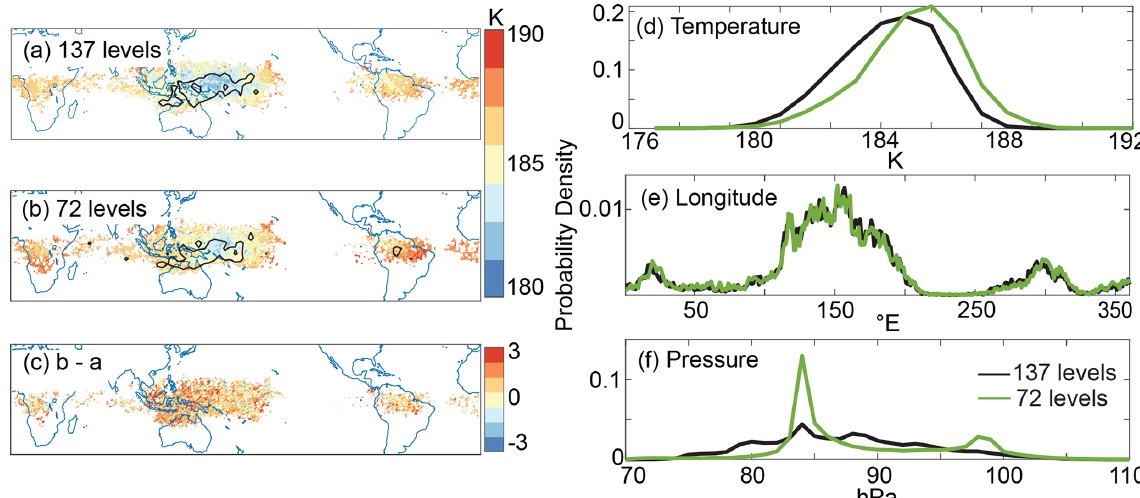
Figure 6. Panels (a–c) display spatial distribution of the DJF 2017 trajectories’ cold point temperature for 137- and 72-level data, and the difference in temperature between the 72- and 137-level trajectories. Black contours in (a) and (b) denote regions where the fraction of trajectories crossing grid cells is greater than 0.03%. Panels (e–g) display probability density functions (PDFs) of the cold point temperature, potential temperature, and pressure for 137 and 72 vertical-level trajectories.